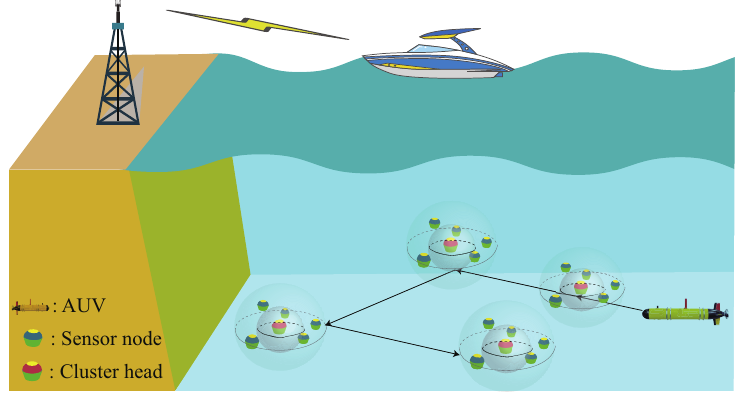
Figure 1. Illustration of the underwater network